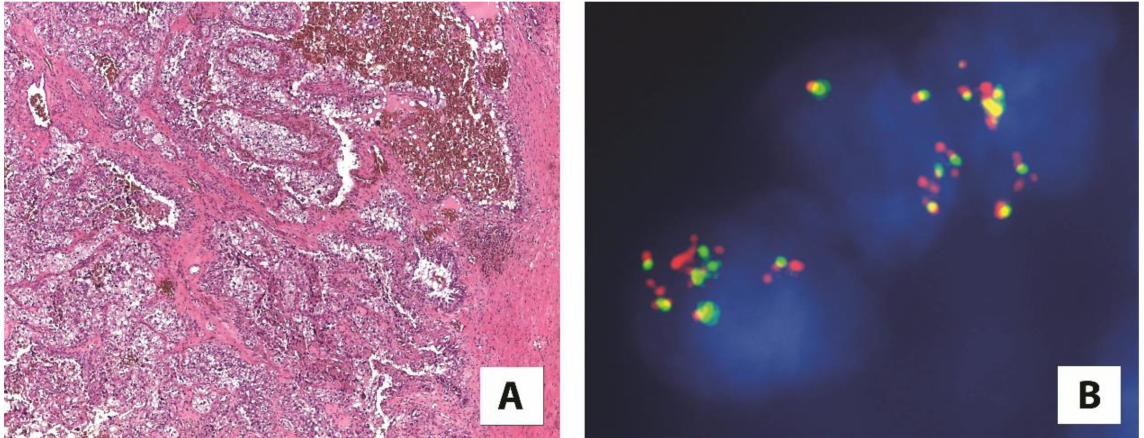
Figure 2. ( A ) A high-grade renal cell carcinoma showing (5 × ) ( B ) TFEB amplification by fluorescence in situ hybridization (FISH) (100 ×